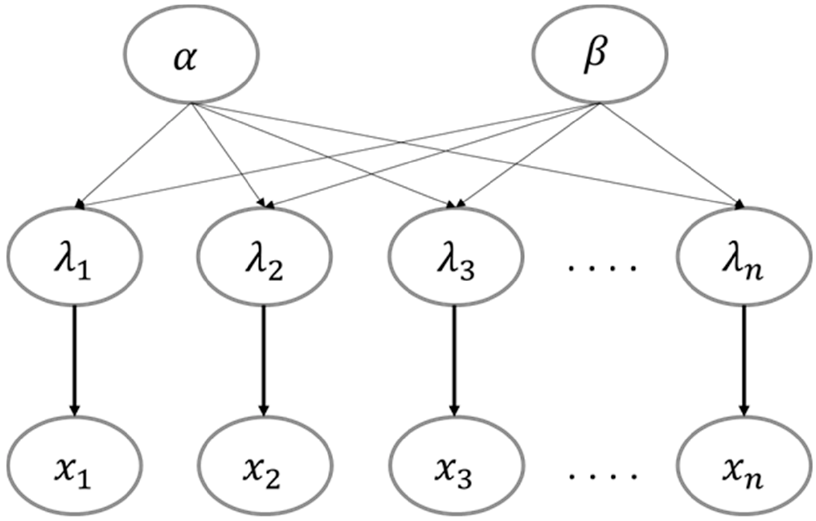
Figure 2. The directed acyclic graph of the hierarchical Bayesian modeling (HBM) .